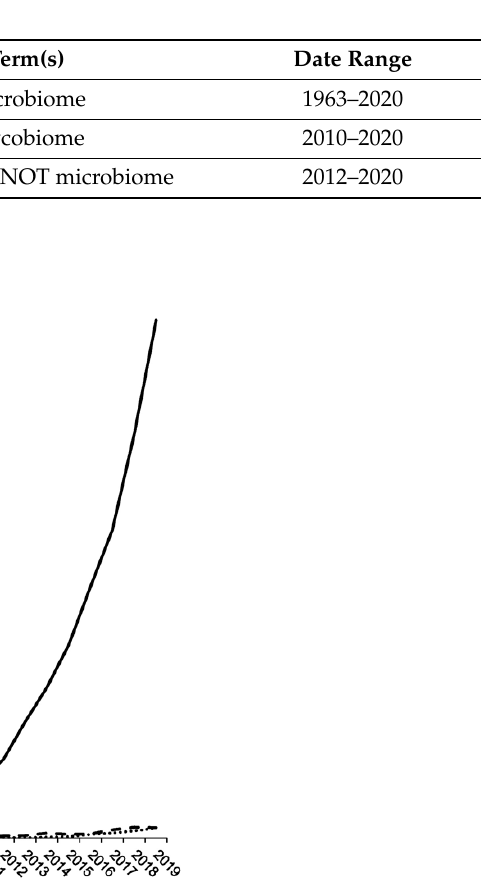
Figure 1. Annual use of “microbiome” in abstracts citing genetic markers 16S, 18S, or ITS. Search conducted June 11, 2020 on PubMed, and including studies up to 2019. Inset shows (log 10 ) number of abstracts containing the same terms. Table 2. Cumulative microbiome studies using genetic markers 16S, 18S, or ITS. Search conducted